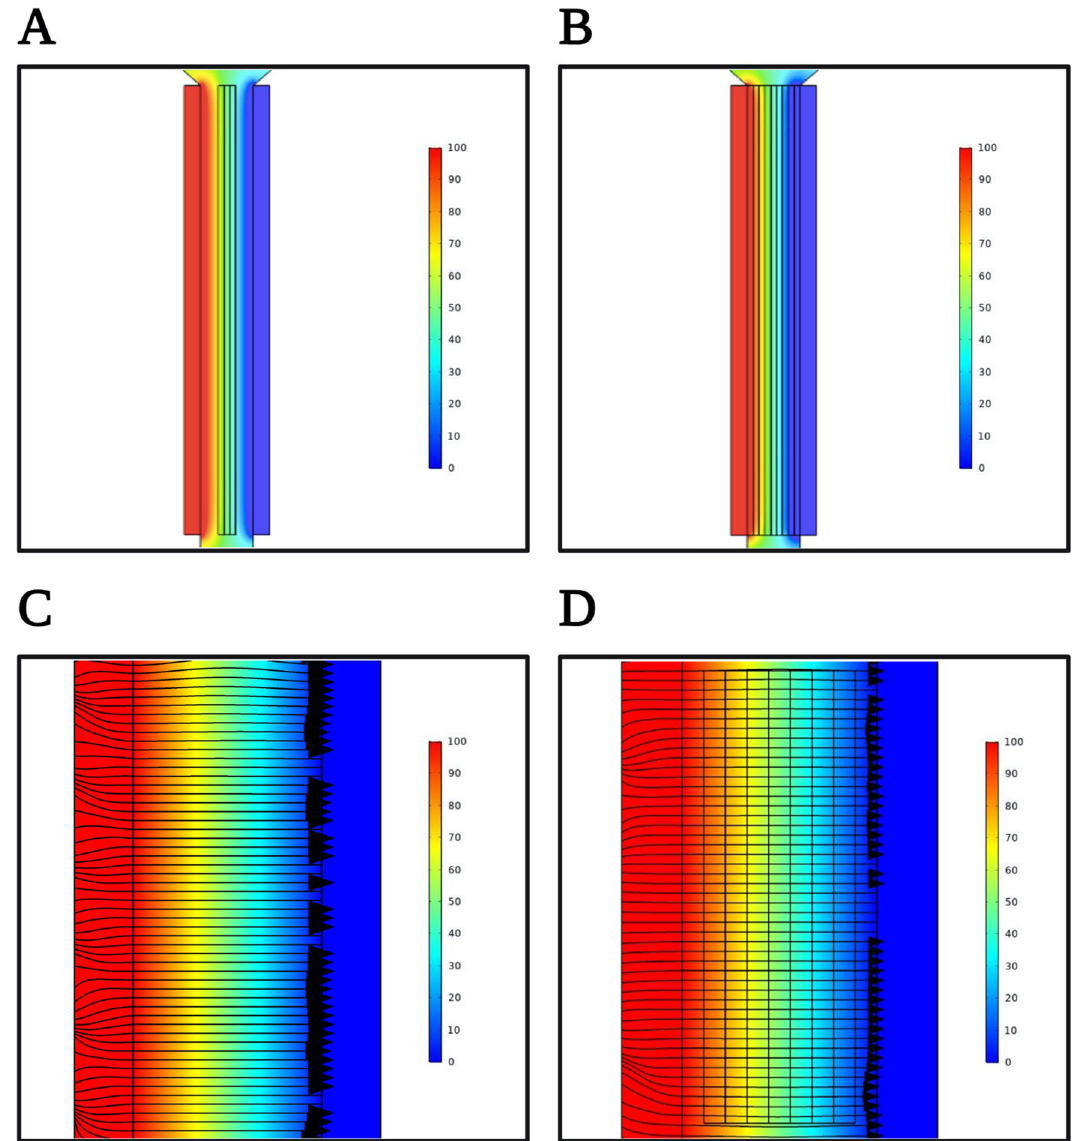
Figure 3. COMSOL finite element modeling of electrical setup. ( A ) Illustrates the electrical model with 3 simulated tissue layers and ( B ) illustrates the electrical model with 9 simulated tissue layers. The tissue layers decrease in conductivity and increase in permittivity to simulate actively dissociating tissue cores. ( C ) Uniform electric field lines in electrical cell without simulated tissue, illustrating the linearity of the electric field across the cavity. ( D ) Uniform electric field lines in electrical cell with simulated tissue model, illustrating that the electric field linearity is not disrupted by the presence of tissue within the